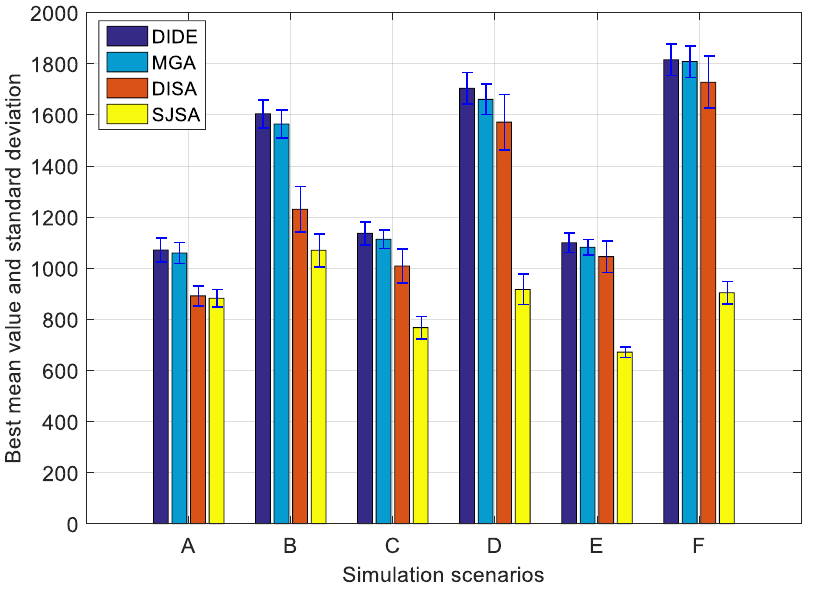
Figure 8. Performance comparison among